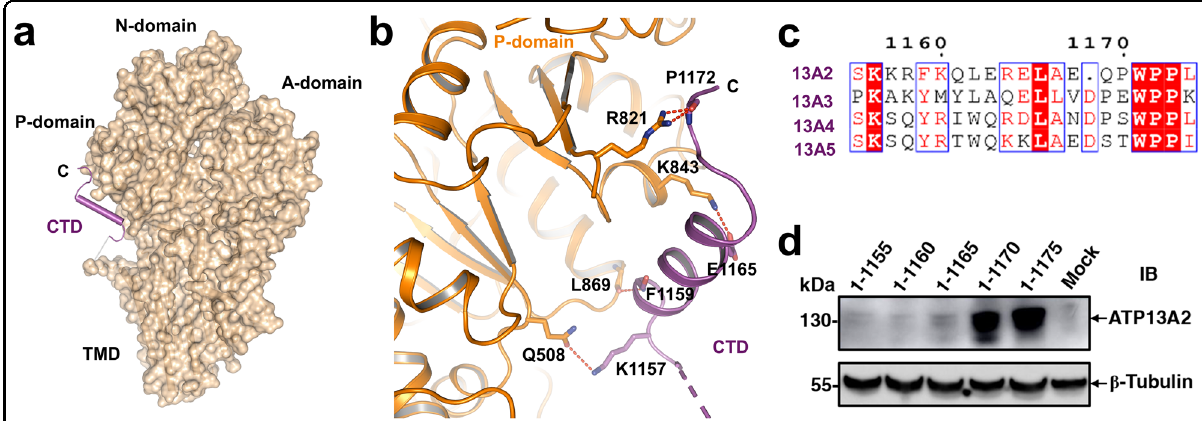
Fig. 2 CTD of ATP13A2 interacts with P-domain, affects protein expression and stability. a Overall structure of E1P-ADP state ATP13A2 in surface representation. The CTD is shown as a purple stick model. b Ribbon representation of the domain interface between CTD and P-domain. Polar interactions are shown as red dashed lines. c Sequence alignment of the CTD of human ATP13A2 to ATP13A5 using ESPript3. Residues are considered as highly similar are colored in red and framed in blue. d Immunoblotting of HEK293F overexpressing fi ve ATP13A2 CTD deletion truncations (5, 10, 15, 20, and 25 amino acids were deleted from C-terminus,